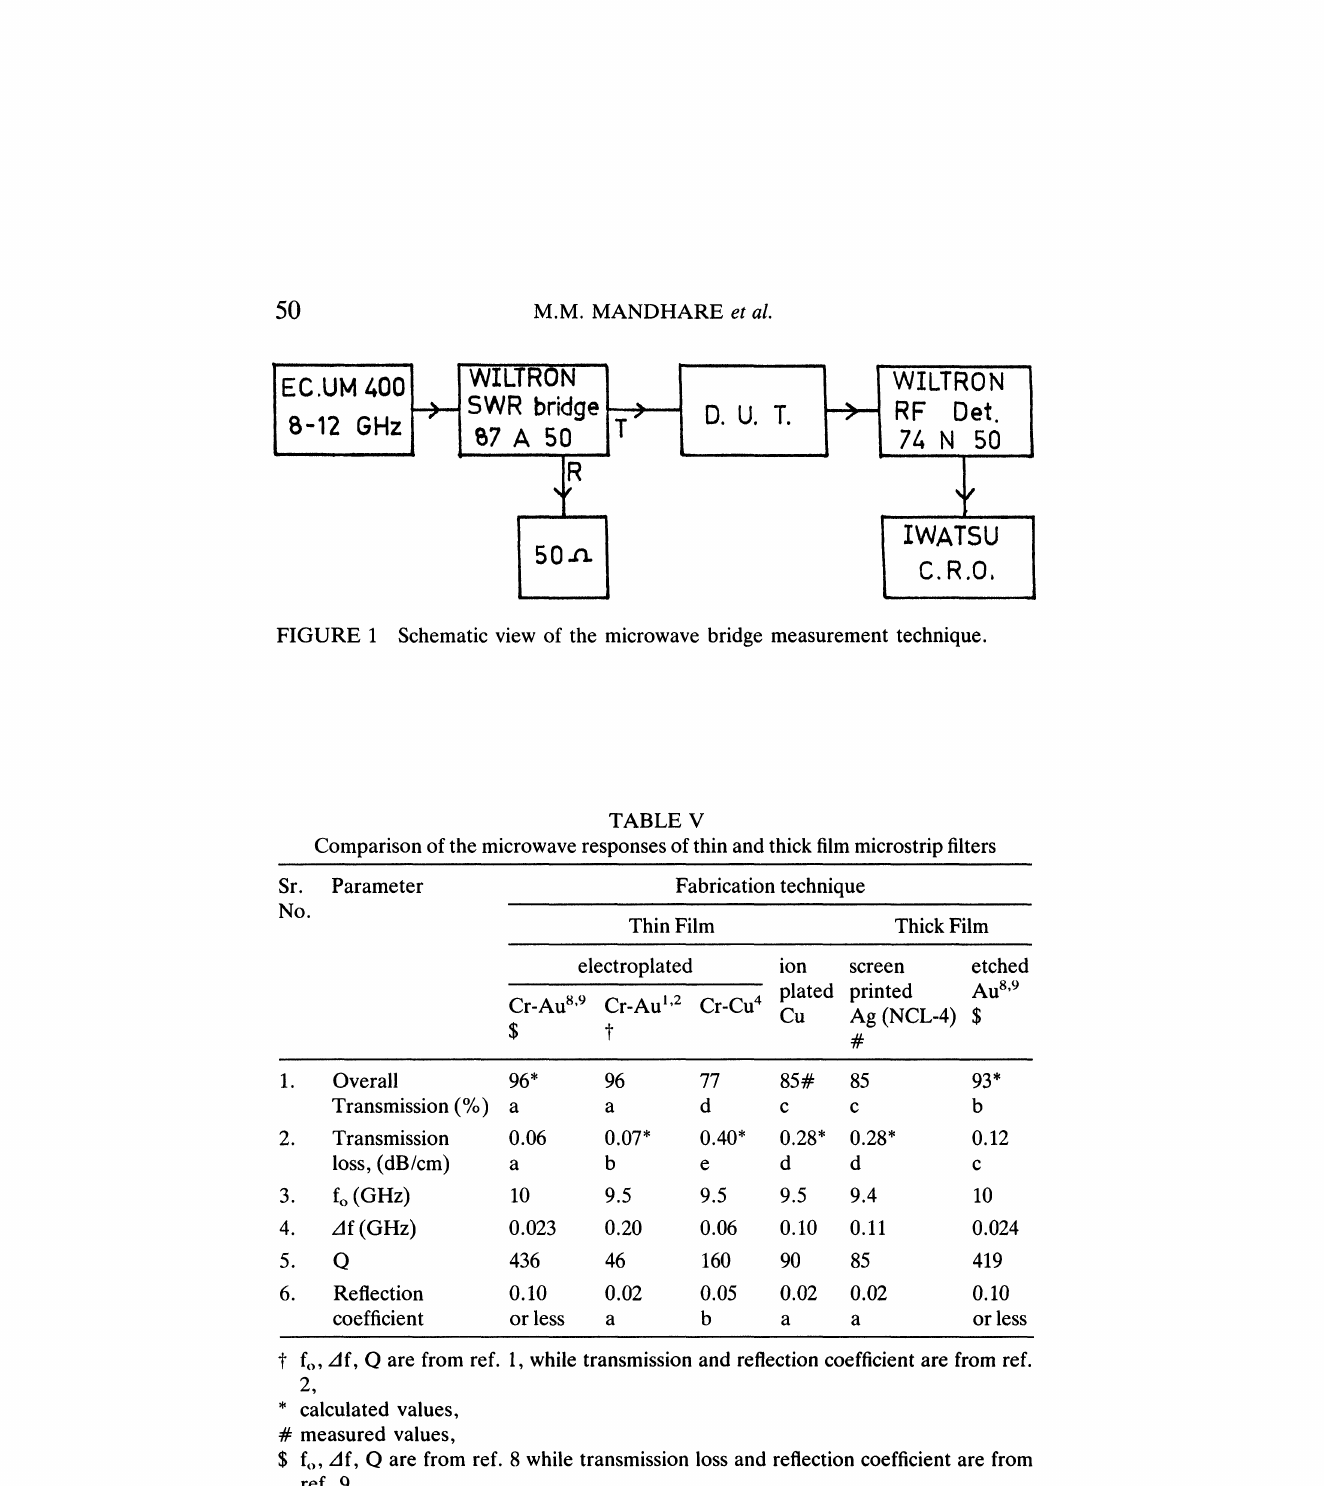
Schematic view of the microwave bridge measurement technique.